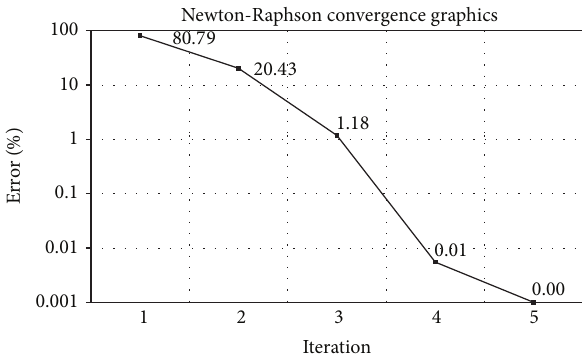
Figure 5: Newton-Raphson convergence graphics for the nonlinear FEM. The graph is plotted using the logarithmic scale.